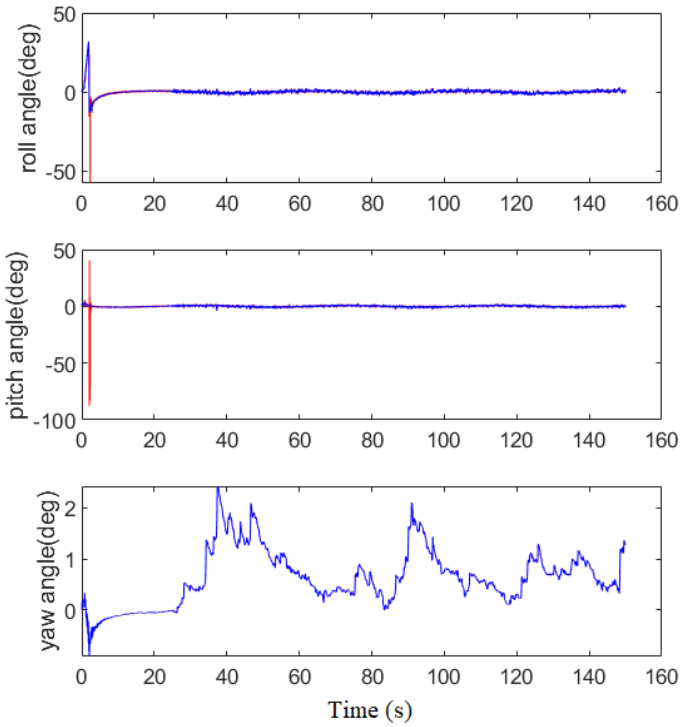
Figure 16. Bias fault: Euler angle estimation (red line–estimated angle, blue line–actual angle